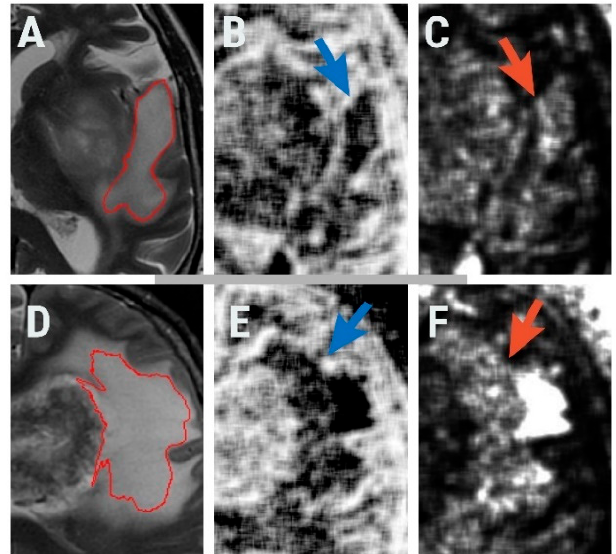
Figure 4. Axial T2-weighted image of a 61-year-old patient with glioblastoma ( A ) and the region of interest (red) used for texture analysis; ( B ) generated map based on short-run emphasis parameter (blue arrow pointing to the peritumoral zone); ( C ) generated map based on long-run emphasis parameter (orange arrow pointing to the peritumoral zone; axial T2-weighted image of a 68-year-old patient with brain metastases ( D ) and the region of interest (red) used for texture analysis; ( E ) generated map based on short-run emphasis parameter (blue arrow pointing to the peritumoral zone); ( F ) generated map based on long-run emphasis parameter (orange arrow pointing to the peritumoral zone.